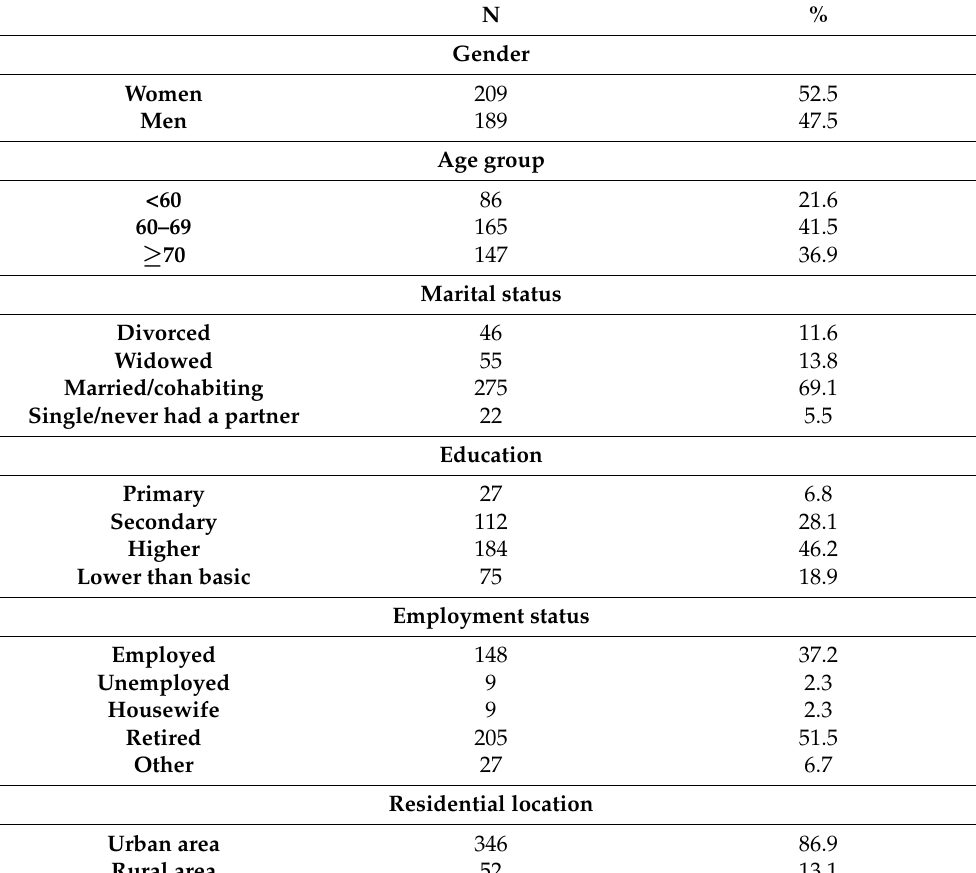
Table 1. Demographic characteristics of the study population.